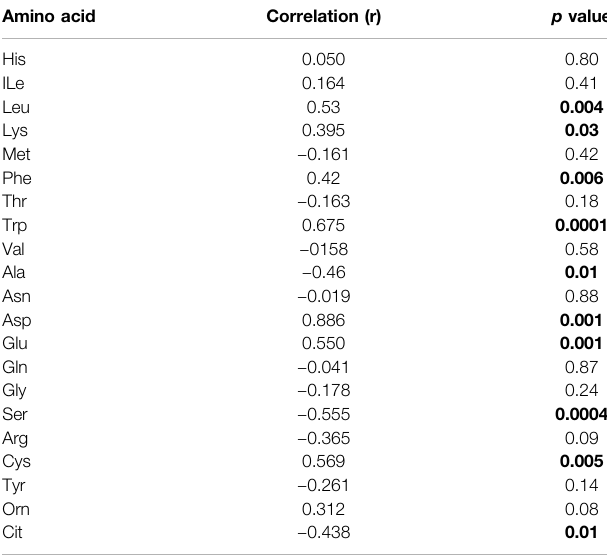
TABLE 2 | Correlation analysis between FBG and amino acids concentrations in T2D. Amino acid Correlation (r) p value His